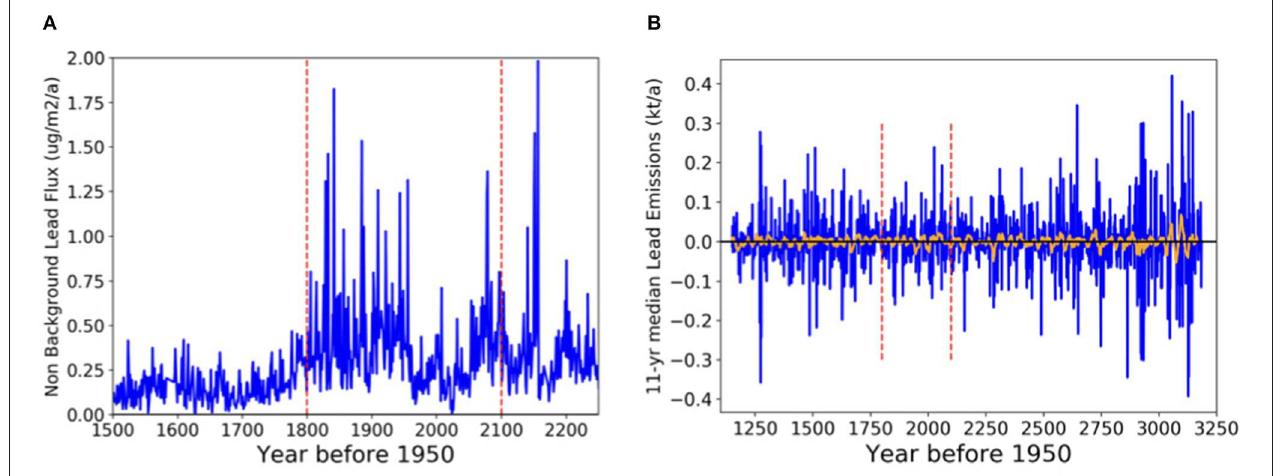
FIGURE 3 | Production and volatility measured by lead emissions [measured in Greenland ice cores, McConnell et al. (2018), data available online at https://www. pnas.org/content/suppl/2018/05/09/1721818115.DCSupplemental]. (A) Shows estimated emissions over a long historical period. (B) Shows the corresponding growth rate in emissions (orange is a running average). Red vertical lines delimit the period between 150BC and 150AD, associated with a rise of the Roman Empire (Delile et al., 2014). For this period the effective growth rate is very small due to high volatility. The annual average growth rate is about η